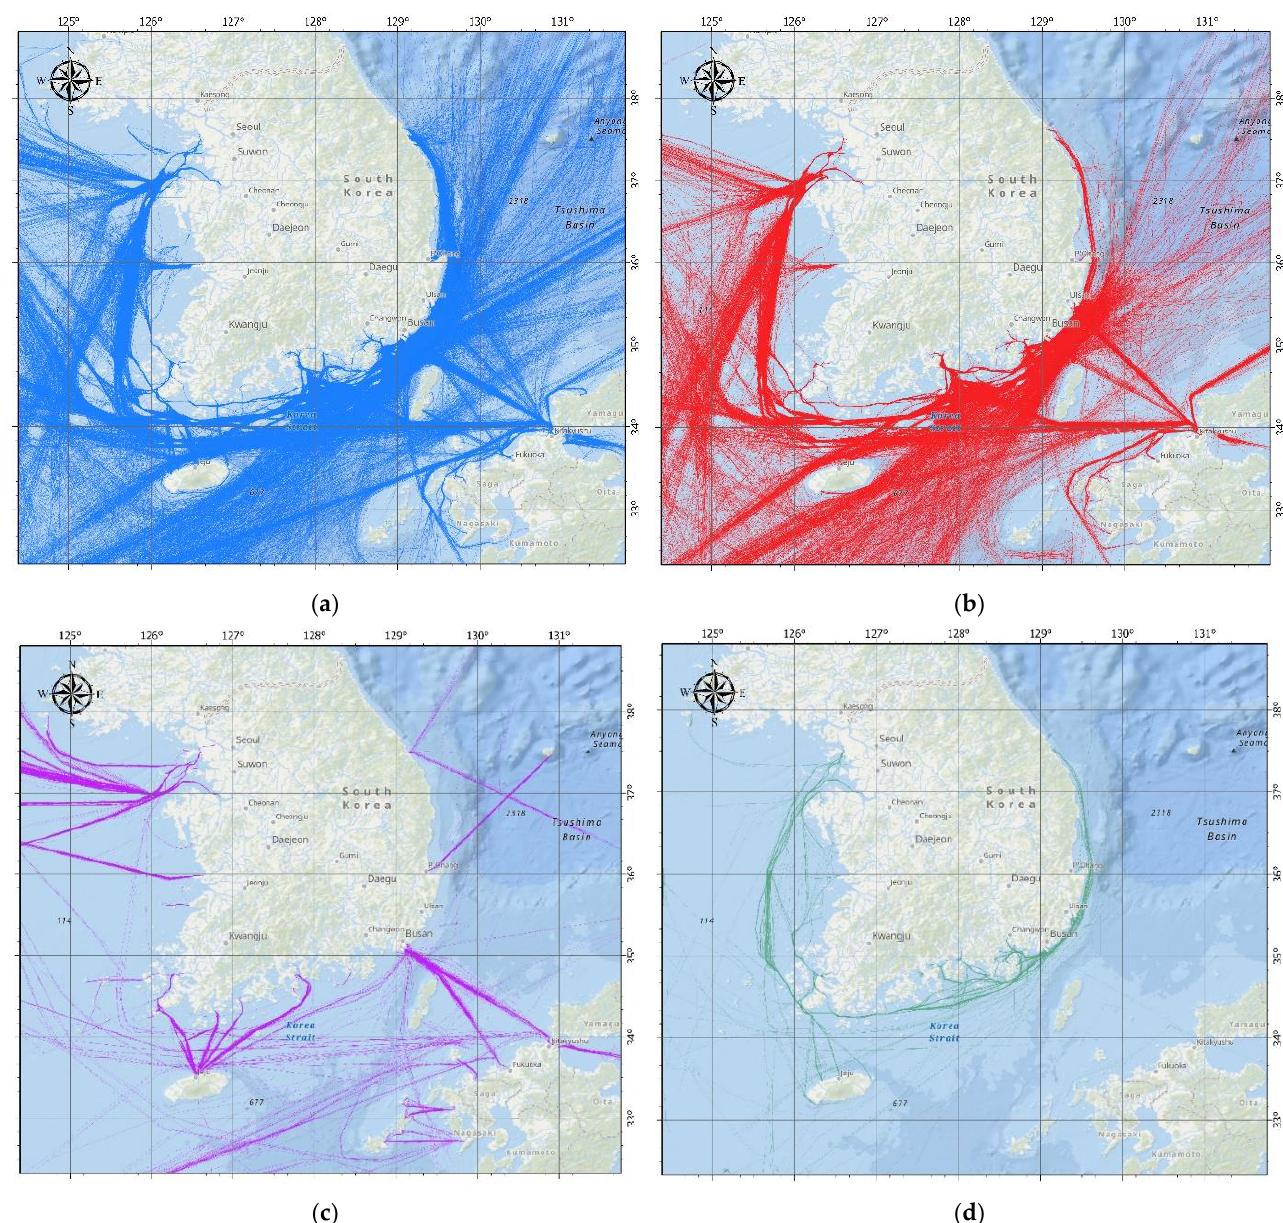
Figure 4. Trajectory line segments constructed from consecutive position points in AIS data: ( a ) cargo ships, ( b ) tankers, ( c ) passenger ships, and ( d ) towing ships.